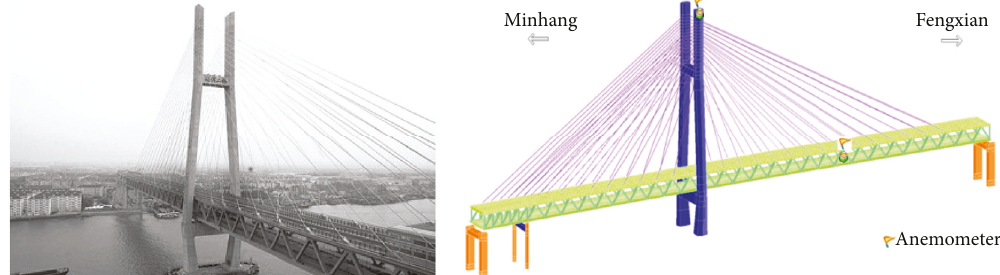
Figure 2: Aerial view of Minpu Second Bridge and the layout of anemorumbometers.